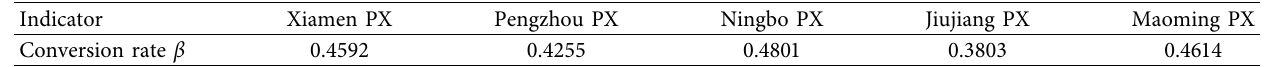
Table 4: Conversion rate β of the silent to the disseminator in the five PX projects.